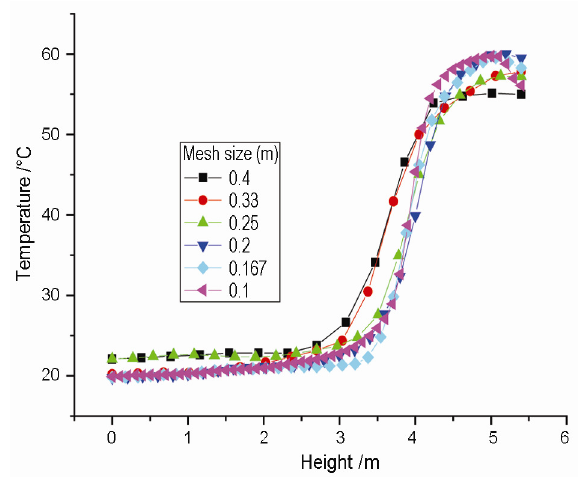
Fig. 4. Vertical temperature distribution in the tunnel with diffe- rent grid